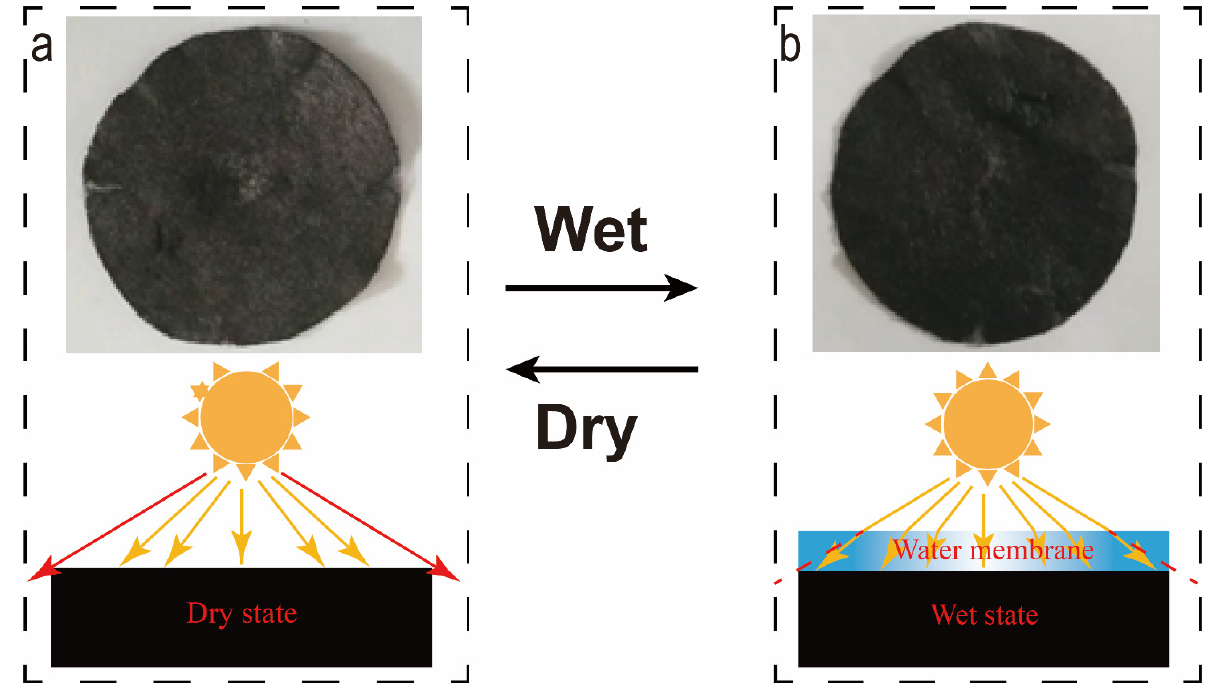
Figure 6. ( a , b ) Physical picture of color difference of photothermal membrane under dry and wet conditions (upper part) and corresponding schematic diagram (lower part, the yellow lines indicate absorbed light and red lines indicate escaping light).